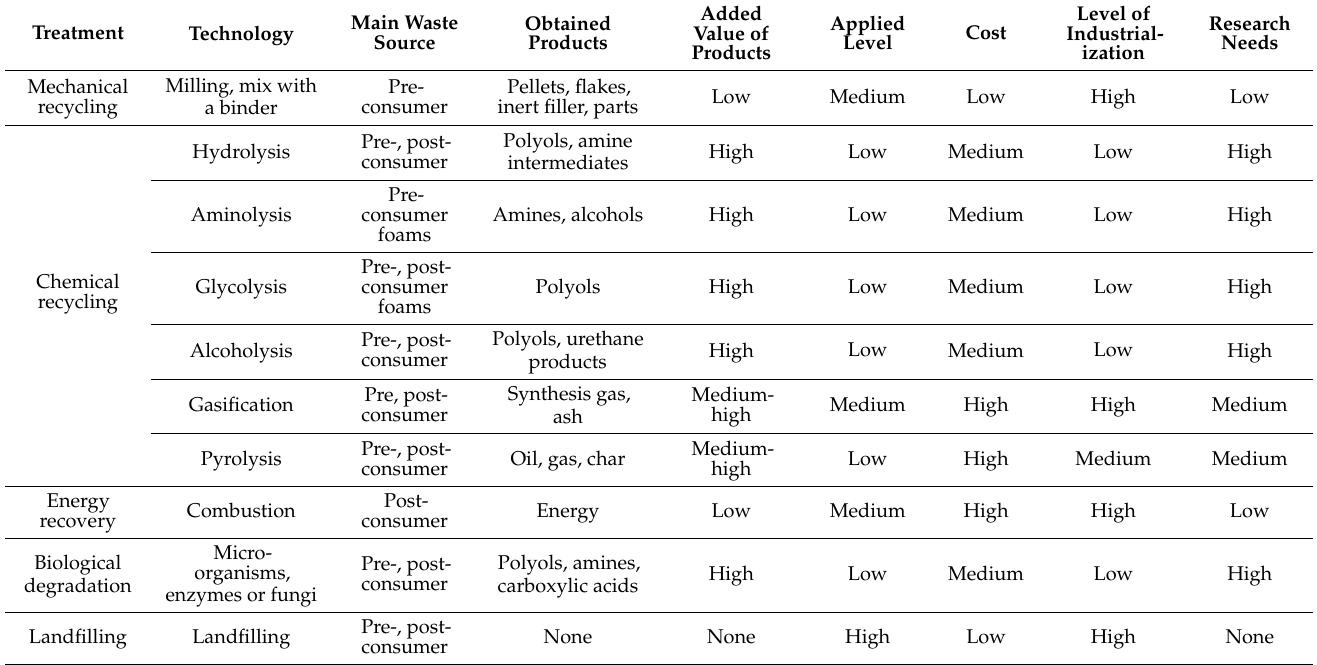
Table 1. Current strategies for recycling